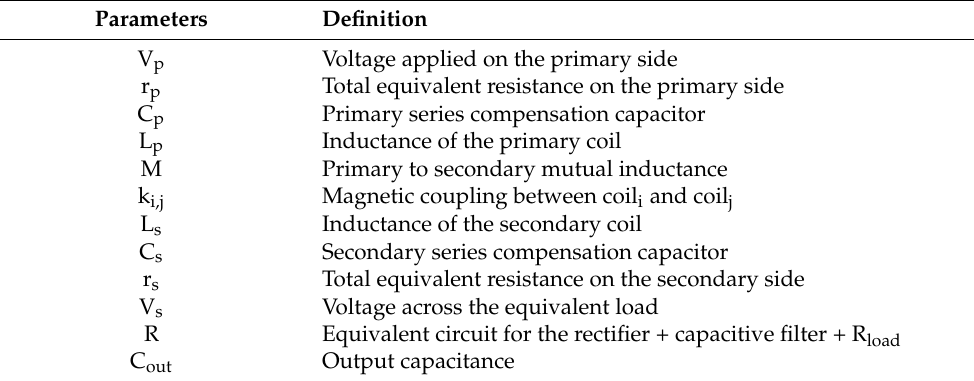
Figure 3. Coupler model with series – series compensation with one transmitter and one receiver. Table 2. Parameter’s definition .